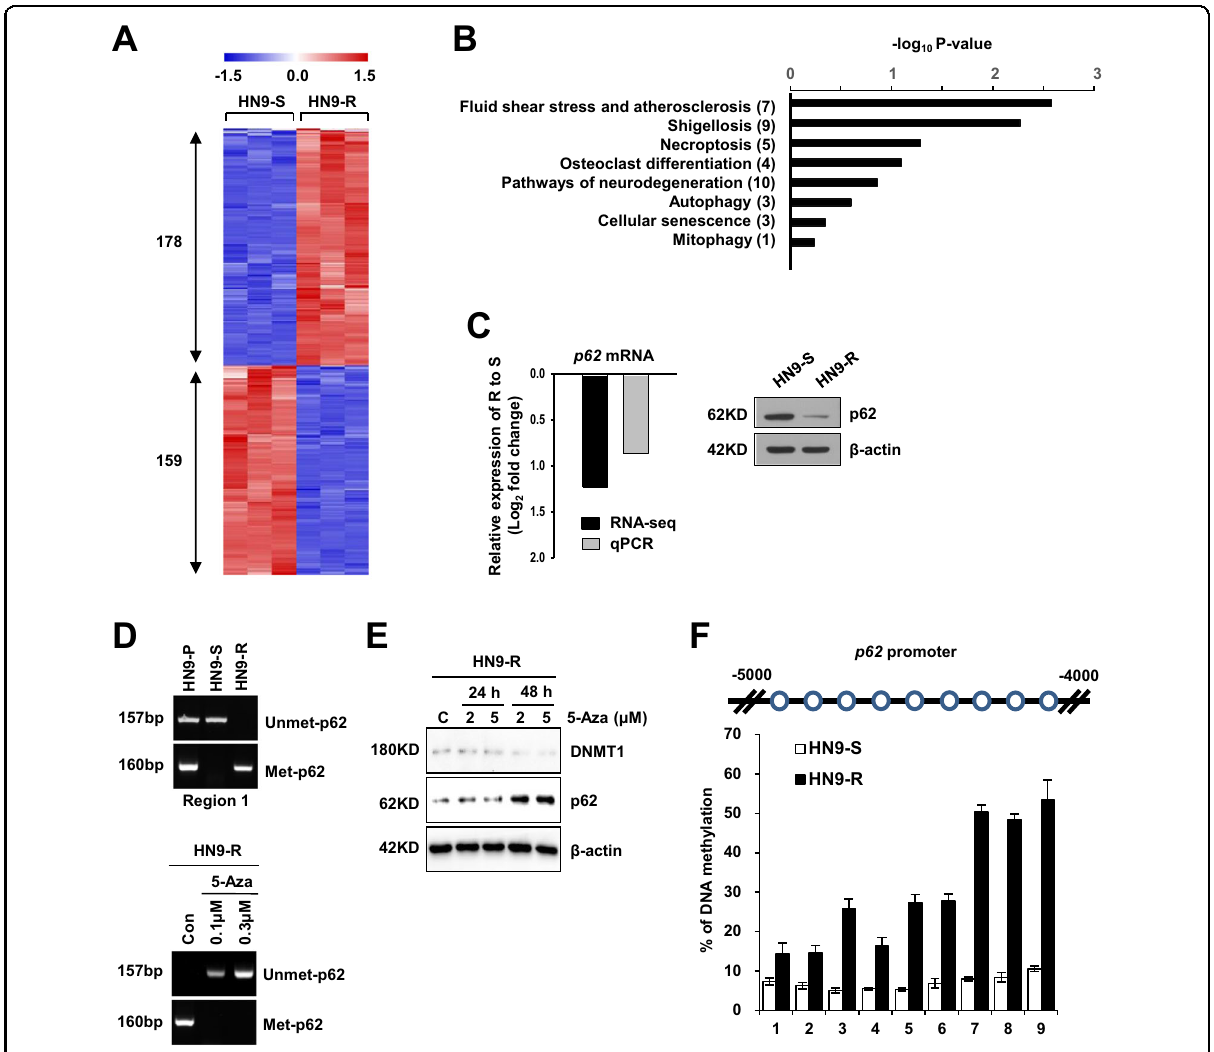
Fig. 2 RNA-seq and methylation analyses show that HN9-R is hypermethylated by DNMT1 on the p62 promoter regions. A Heatmap of differentially expressed genes (DEGs) between the HN9-S and HN9-R clones by RNA sequencing analysis ( n = 3). The number of genes with increased and reduced in HN9-R relative to HN9-S clones were displayed. B Enriched Kyoto Encyclopedia of Genes and Genomes (KEGG) pathways associated with p62 among DEGs between HN9-S and HN9-R clones. The y-axis displays the names and total number of genes of each pathway. DEGs signi fi cance was set at FDR ≤ 0.05 and |log2 FC | ≥ 0.5, and pathway signi fi cance was set at p ≤ 0.01 (Fisher ’ s exact test). C Log 2 fold change comparison of RNA-seq and qRT-PCR (left) for p62 and western blotting (right) were used to validate the RNA sequencing data. Negative values indicate that p62 gene expression was downregulated in HN9-R compared to HN9-S clones. D Methylation analysis of the p62 promoter by methylation-speci fi c PCR in three HN9 cells (upper) and in HN9-R treated with DNMT1 inhibitor, 5-Aza (bottom). E Immunoblot analysis of p62 level in HN9-R clones after treatment with 5-Aza. F Bisul fi te sequencing analysis of the p62 promoter in HN9-S and HN9-R clones. The p62 promoter (from forward 4000 to 5000 bp) was analyzed at nine CpG methylation sites using